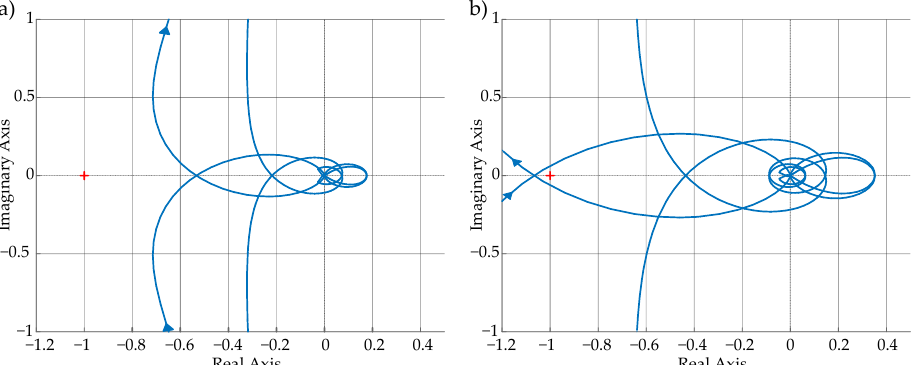
Figure 14. Nyquist diagram for different K ( a ) K = 35, ( b ) K = 70.